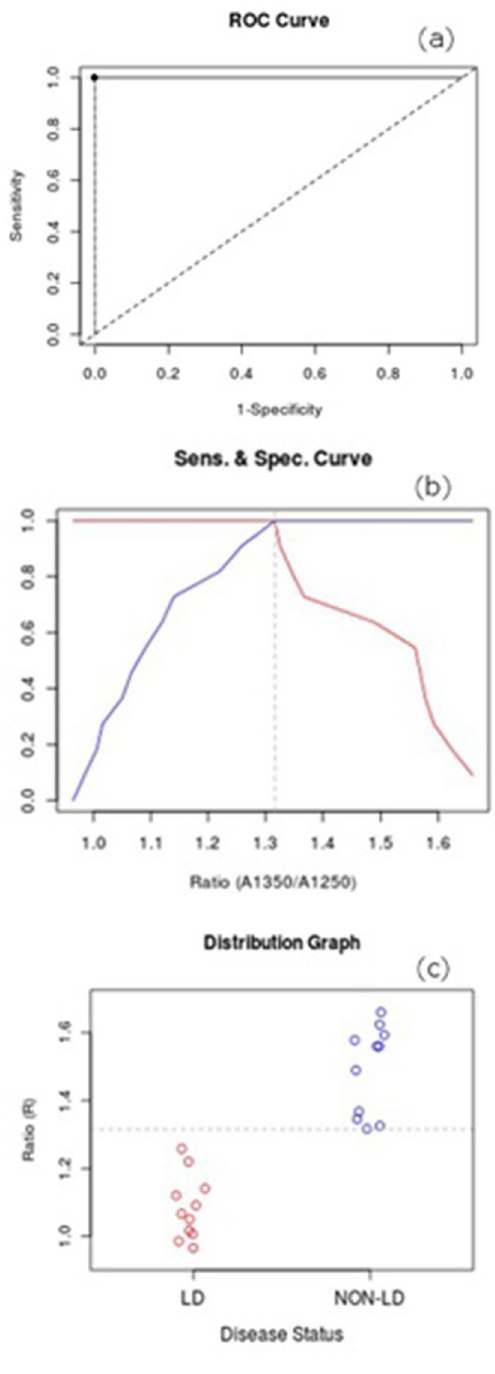
Figure 5. ( a ) ROC curve for the A1350/A1250 ratio (AUC = 1, 95% confidence interval). The diagonal joining the point (0.0) and (1.1) represents the line of equality. The black point corresponds to the 1-Specificity, Sensitivity calculated for the optimal cut-off for correctly identifying Leishmania (LG) or control (CG) subjects. ( b ) Trend of sensitivity (red line) and specificity (blue line) vs. A1350/A1250 ratios. The vertical dot line identifies the optimal cut-off (threshold value = 1.316) and the point of intersection of sensitivity and specificity curves corresponds to the black marker depicted in ( a ). ( c ) Scatter distribution of each group (CG and LG). The optimal cut-off is plotted as the horizontal dot